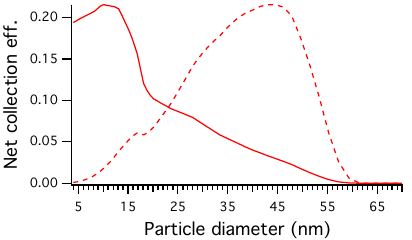
Figure 3. (a) Sum of oxidized sulfur (“sulfate”) signal vs. collected ) signal vs. particle volume. (b) Sum of N base (DMAH + and NH + 4 collected particle volume. Red crosses are from chamber particle collections of DMA + H 2 SO 4 nucleation experiments, and black circles are from calibration ammonium sulfate aerosol. Ion counting errors are smaller than the symbols and are excluded. The negative ion data from the chamber particles are broadly consistent with par- ticles dominated in volume by sulfate. However, the chamber par- ticles have a much lower base fraction than the ammonium sulfate calibration